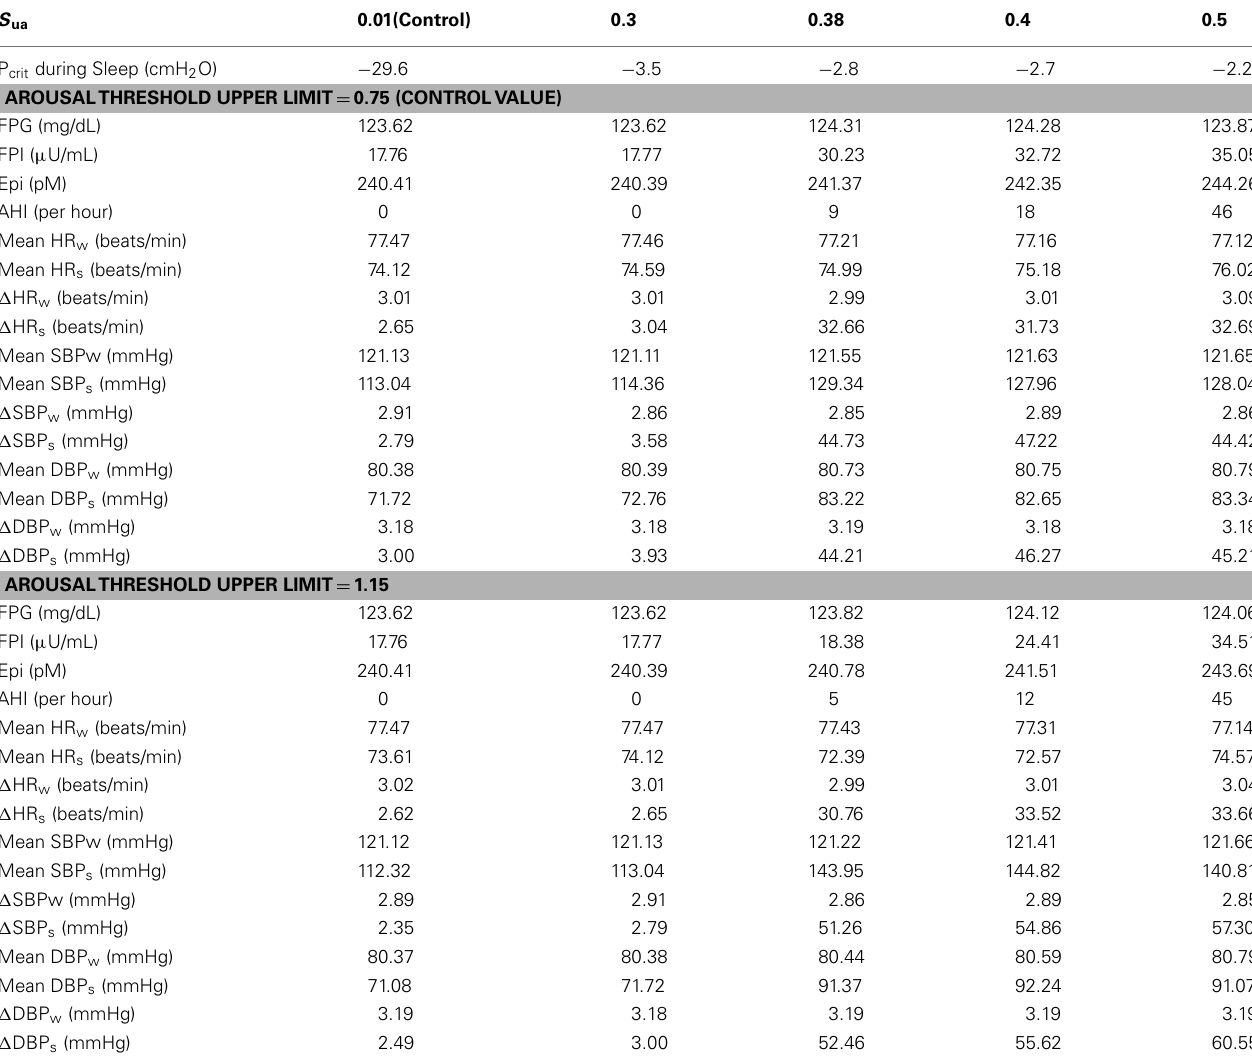
Table 4 | Sensitivity analysis of OSA effects on autonomic and metabolic interactions by changing key parameters in upper airway